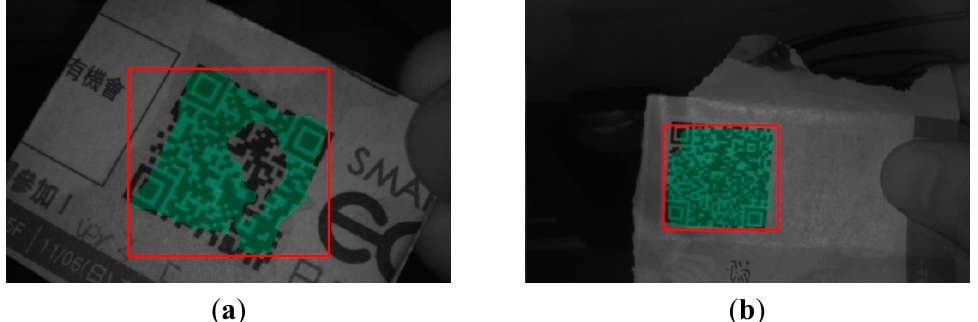
Figure 2. The predicted output of Mask R-CNN model, the quality of mask is very poor. ( a ) and ( b ) show two examples of the Mask R-CNN’s predicting results